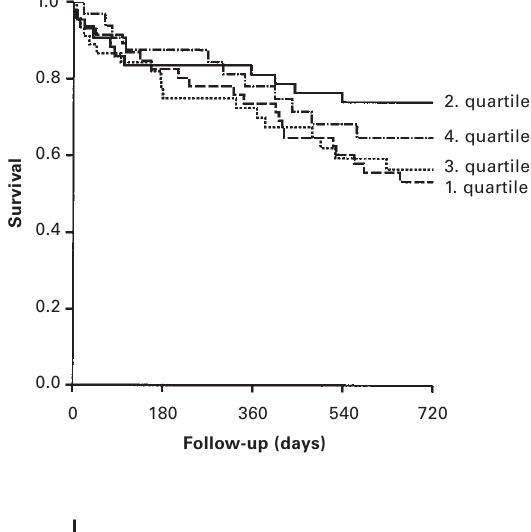
Figure 2 Scatterplot of length of stay against BT, black points indicat- ing patients who died in hospital of cardio- vascular causes and white points indicat- ing patients surviving hospital